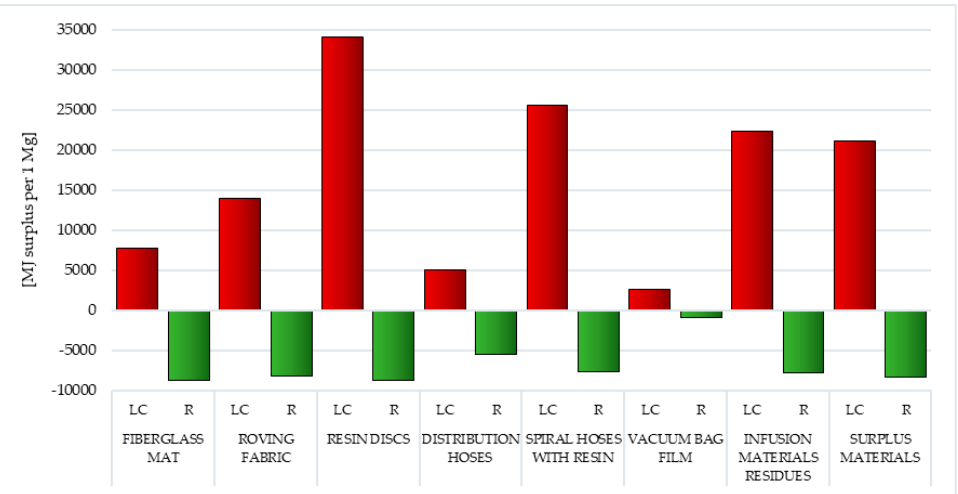
Figure 14. Characterization results of environmental consequences for processes related to the extraction of fossil fuels present in selected postproduction waste of wind power plant blades: LC—life cycle, R—recycling [unit: MJ surplus per 1 mg].